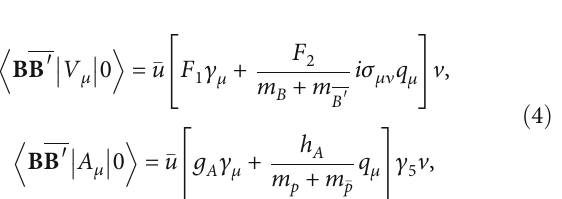
Figure 1: Feynman diagram for (cid:1) B 0 ⟶ p (cid:1) p